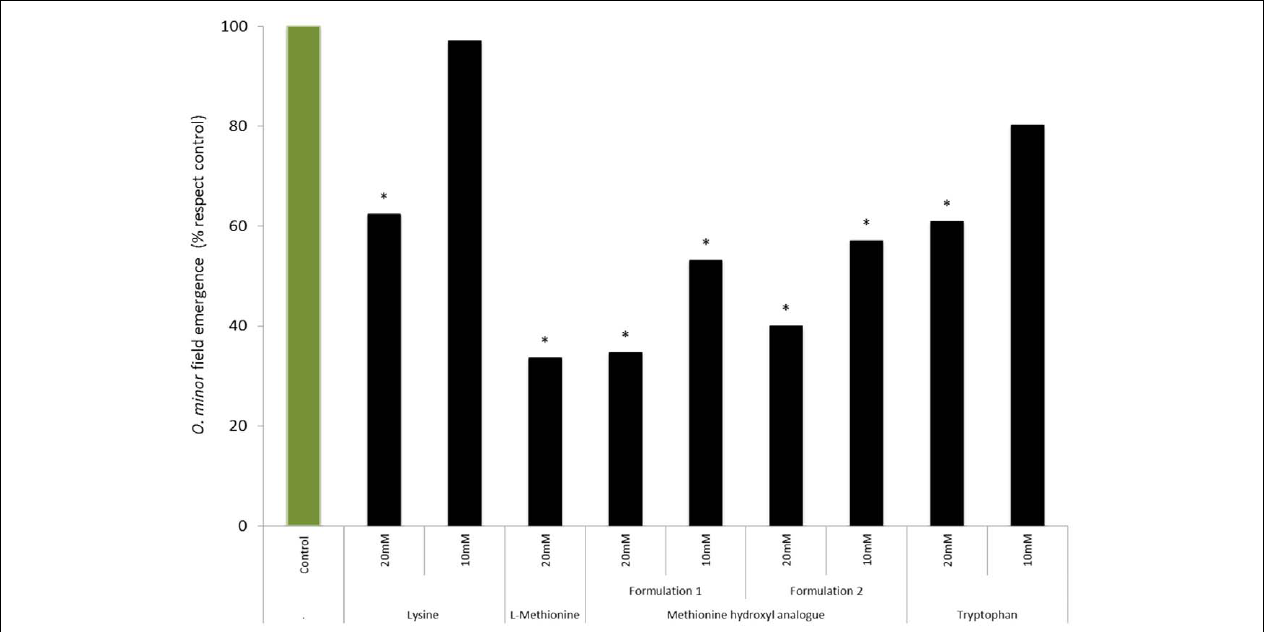
FIGURE 7 | Influence of lysine, L -methionine, methionine hydroxyl analog, and tryptophan field treatments in the emergence of O. minor in red clover during a field trial in Burgundy, France in 2014. ∗ Indicates differences of each treatment compared with the control assessed by Dunnett’s test at the 0.05 level. TABLE 2 | Protective effect of methionine imbibition of red clover seeds against O. minor parasitism. Clover seed Total number of Infection Hypersensitive-like Necrosis of ‘Spider’ imbibition treatment O. minor tubercles success (%) response (%) tubercle (%) development (%) per clover plant Control 28.0